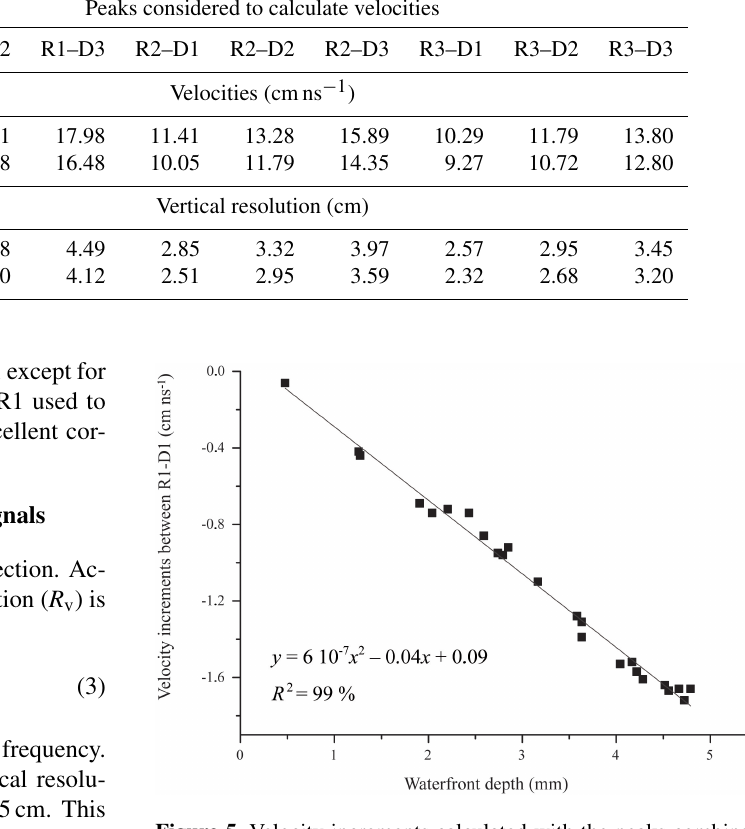
Figure 5. Velocity increments calculated with the peaks combina- tion D1–R1 versus waterfront